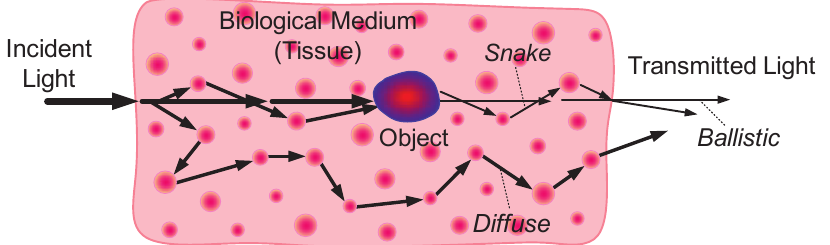
Figure 4. Light propagation through biological tissue.